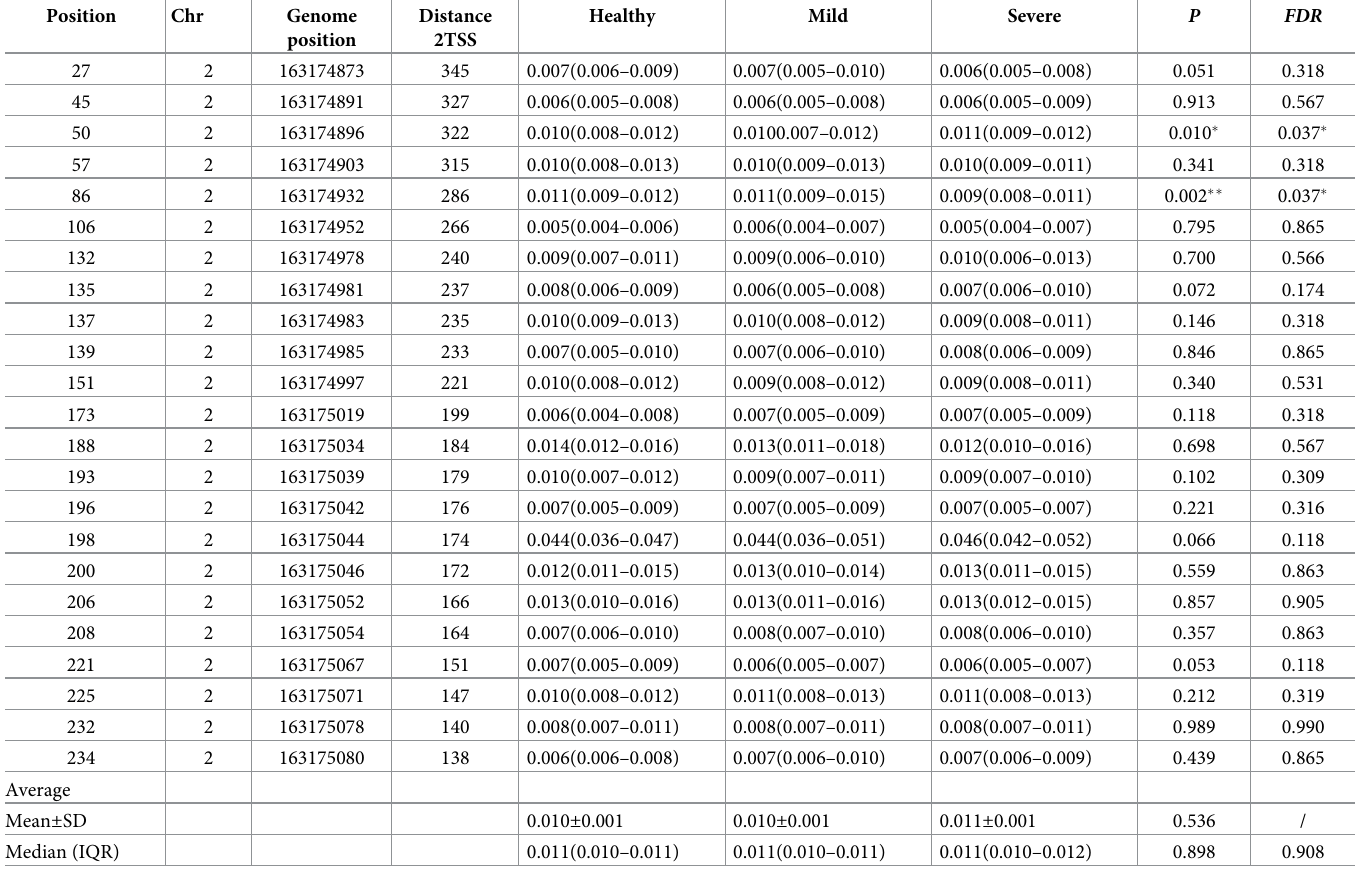
Table 2. Details of the CpG regions in the CpG islands of